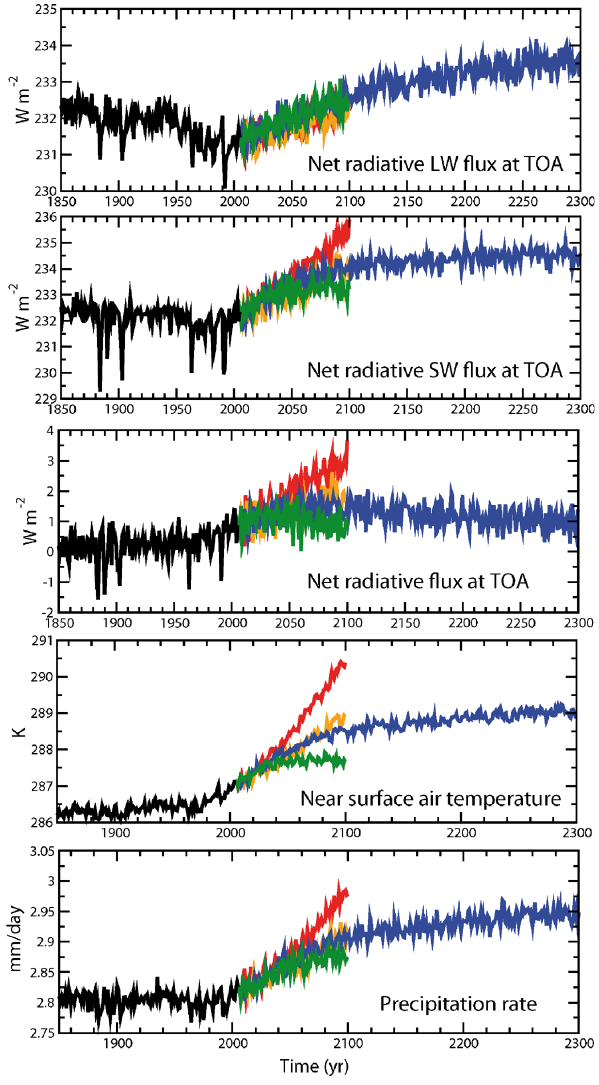
Fig. 3. From the top panel and downwards, the figure shows the net global long-wave (positive upwards), short-wave (positive down- wards), and total (positive downwards) radiative flux at the top of the atmosphere during the NorESM1-M simulations for 1850 to 2300. The next two panels show diagrams for the global surface air temperature and average daily precipitation. Black: Historic1, green: RCP2.6, blue: RCP4.5, orange: RCP6.0, and red: